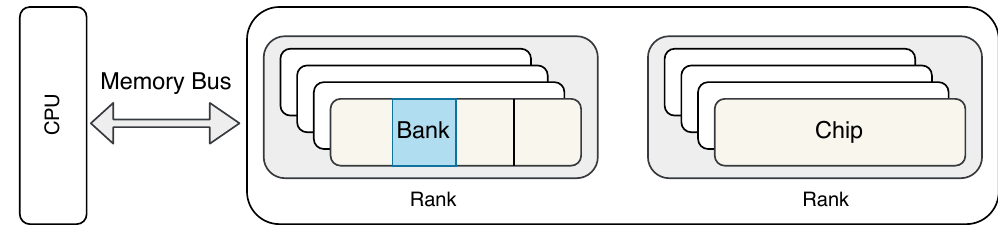
Figure 3. DRAM hardware structure.